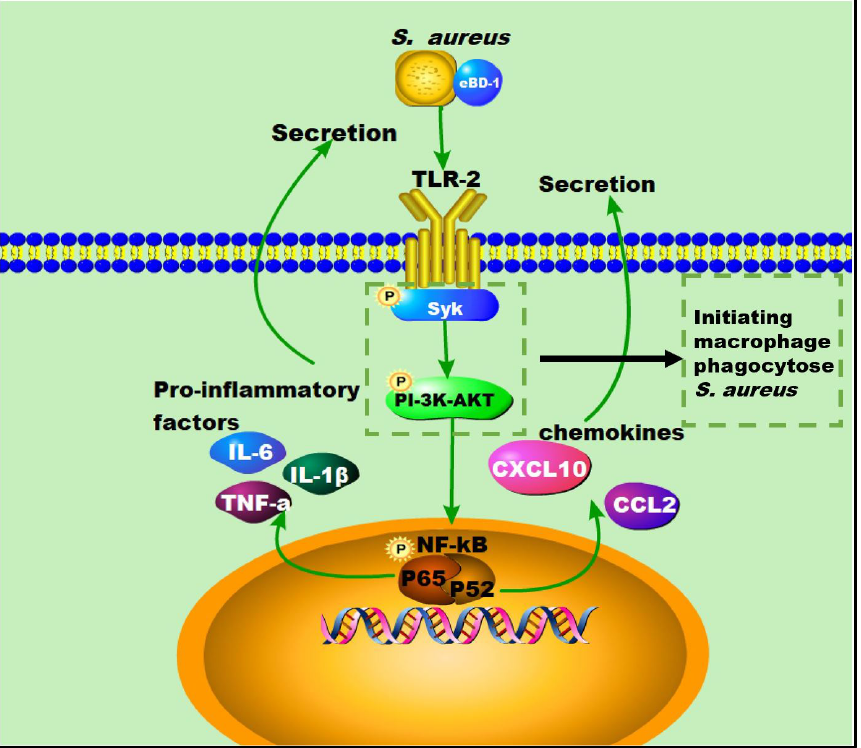
Figure 6. The possible figure according to the results, to illustrate the role of OEBD-1 in S. aureus - infected macrophage, the OEBD-1 promotion macrophage phagocytosed S. aureus via Syk-PI-3K- AKT pathway. Furthermore, OEBD-1 activated TLR2 to upregulated cytokines and